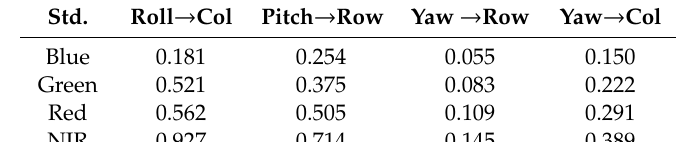
Table 6. Standard deviations in the coordinate di ff erences between MS and PAN images for attitude changes.